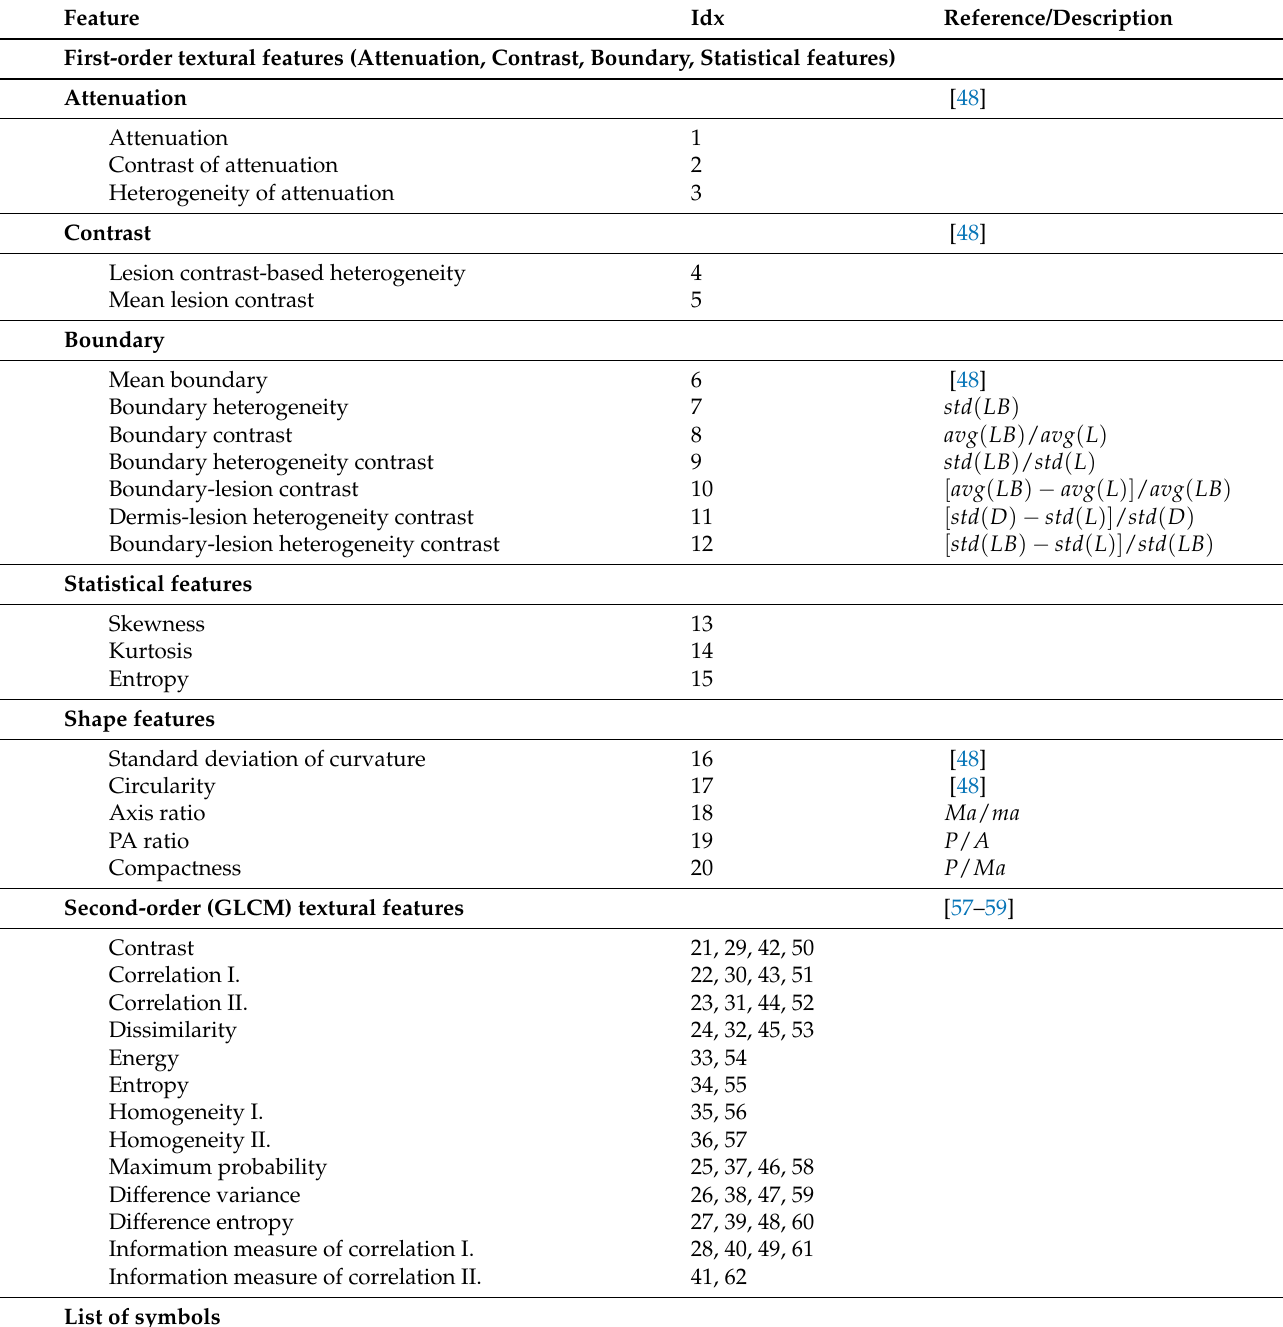
Table 2. Feature set used for ultrasound-based skin lesion